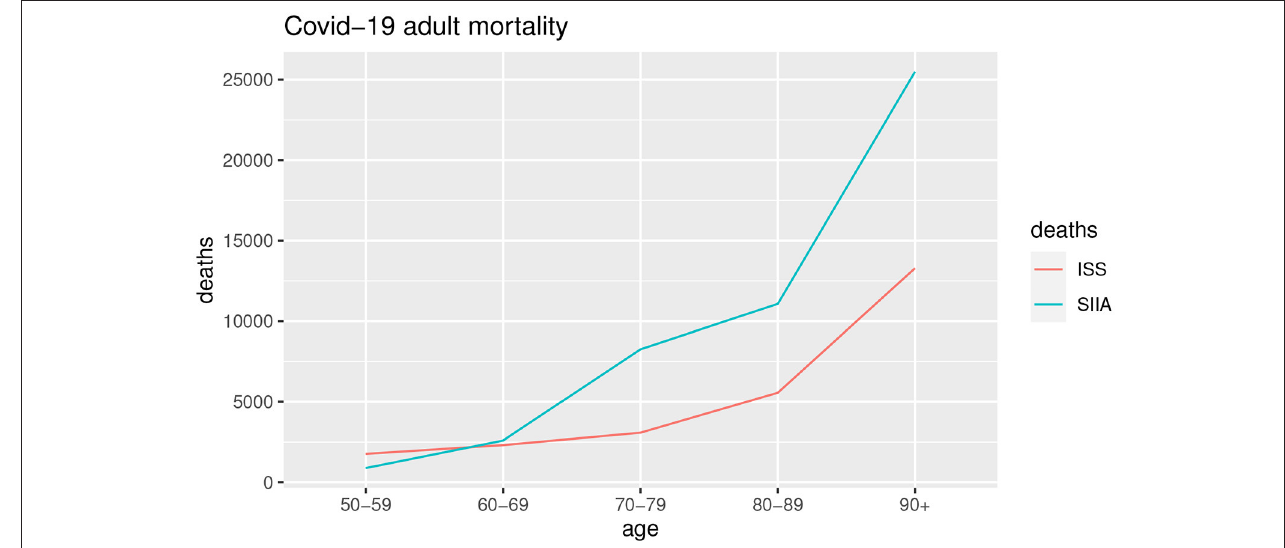
FIGURE 4 | Estimation of non-COVID-19 deaths. Adult ages.